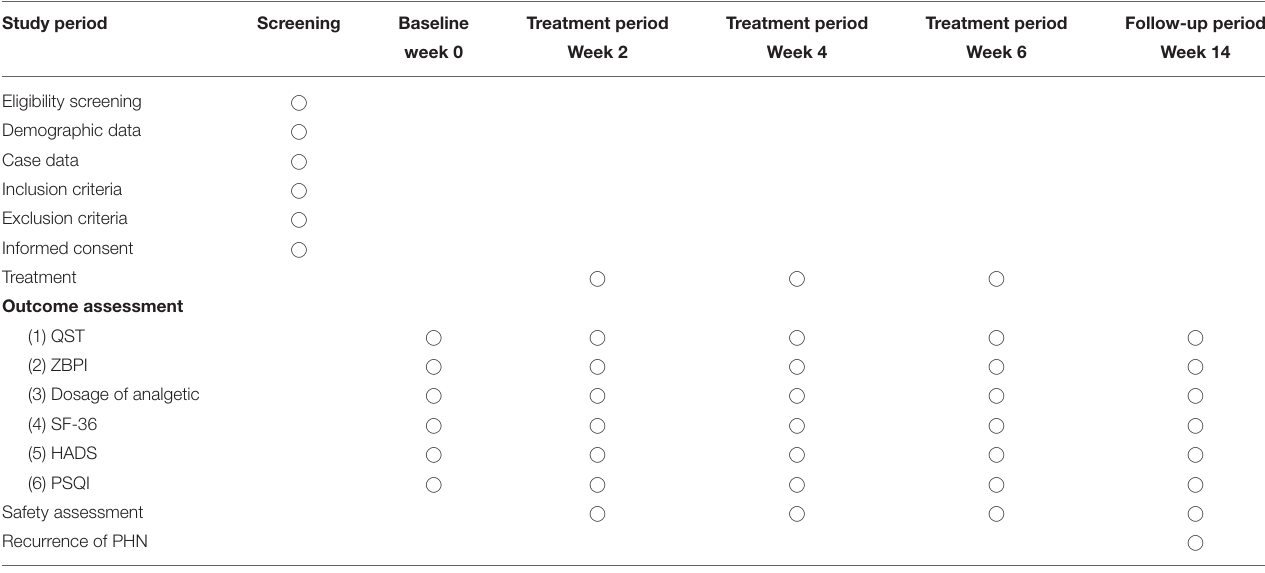
TABLE 1 | Schedule of enrolment, treatments, and assessments.